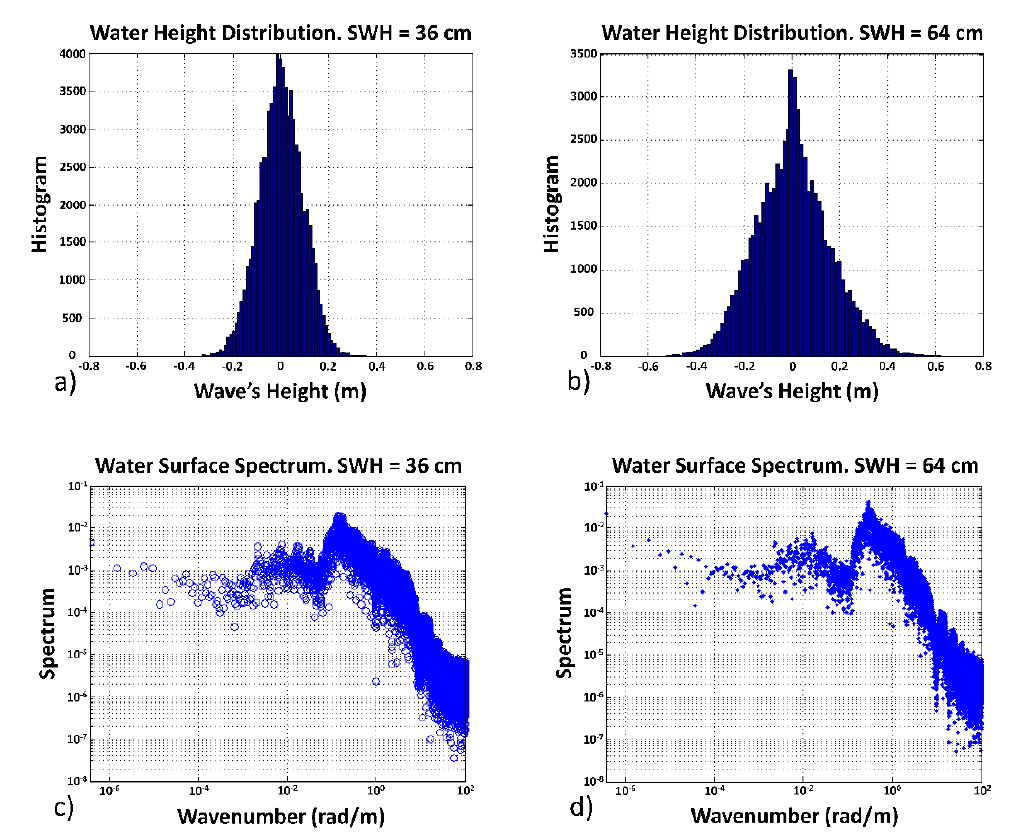
Figure 9. Surface height distributions obtained using the HR Wallingford wave probe monitor for a: ( a ) SWH = 36 cm and ( b ) SWH = 64 cm. Corresponding wave surface spectra for a: ( c ) SWH = 36 cm and ( d ) SWH = 64 cm at the